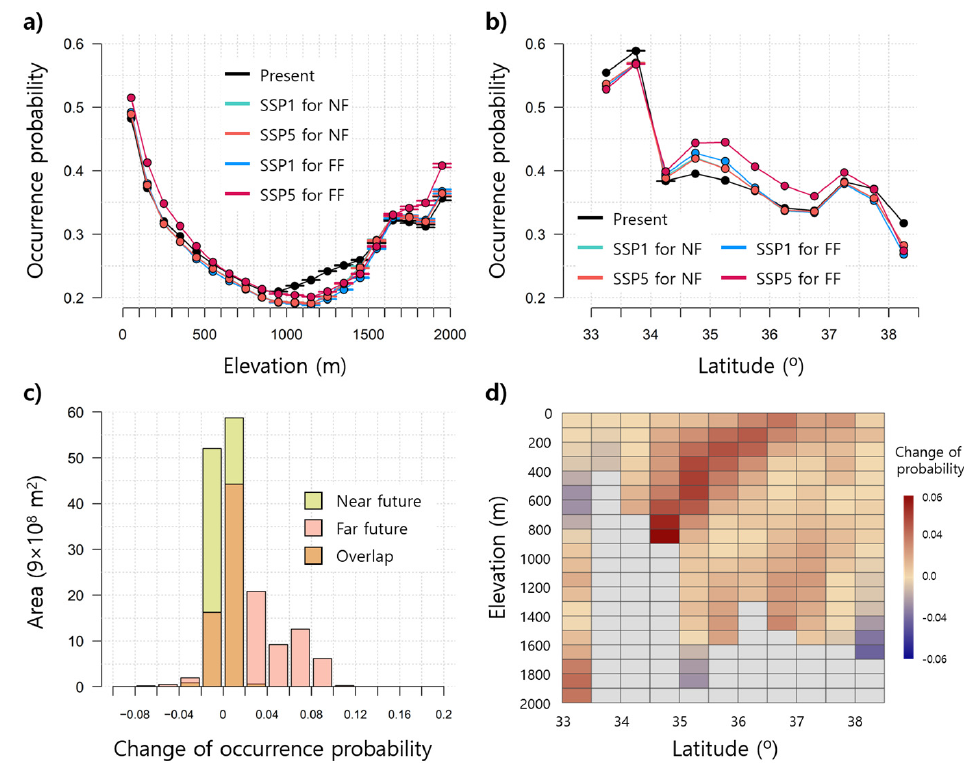
Figure 7. The effects of climate change on the occurrence of WCSBs in South Korea. All values in the figure are interval values. Change in the occurrence risk of WCSBs according to ( a ) elevation and ( b ) latitude (NF: near future (2021–2040); FF: Far future (2061-2080)). ( c ) Impacts of intensified climate change in the future. ( d ) Change in the occurrence risk of WCSBs between climate change scenarios in the far future. The degree of change in the near future and the far future ( c , d ) was obtained by subtracting probability under SSP5-8.5 from probability under SSP1-2.6. Grids with gray color mean no data.